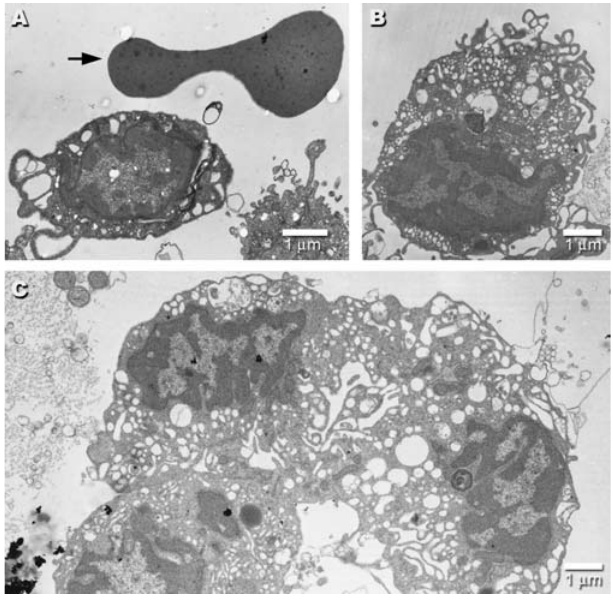
Figure 1. EMs of Day 0 Spoc Cells